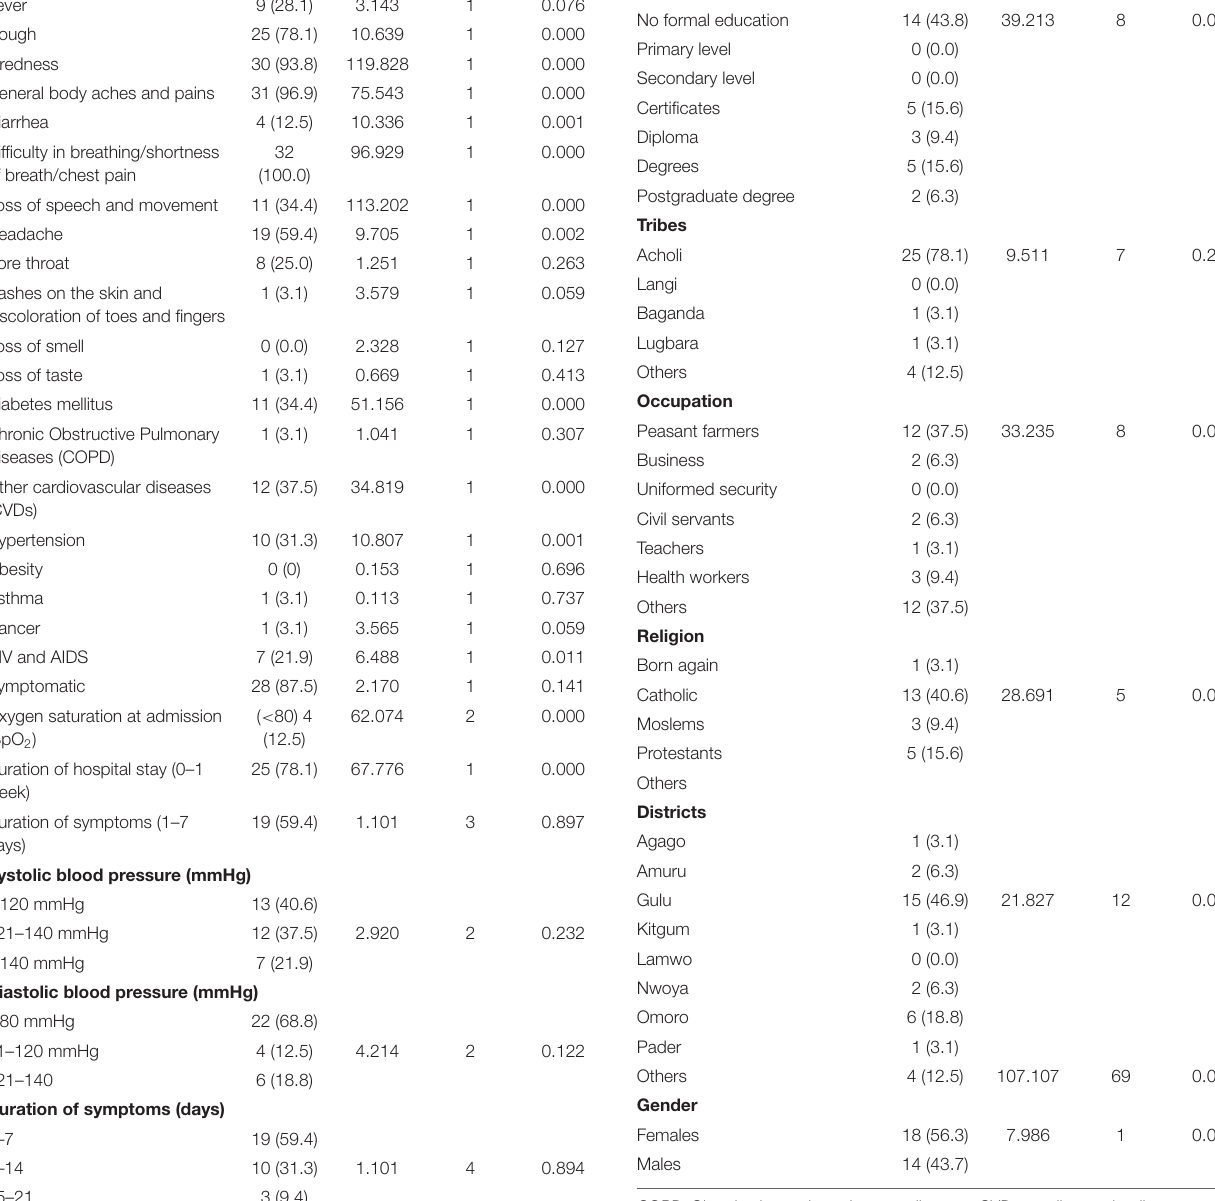
COPD, Chronic obstructive pulmonary diseases; CVDs, cardiovascular diseases.